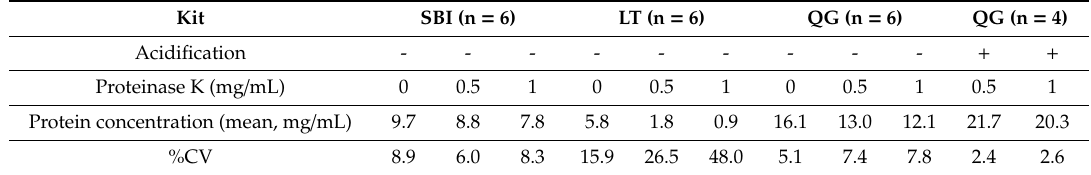
Table 2. Comparison of protein concentration and its variability according to the exosome-like extracellular vesicle (ELV) preparing methods. QG, miRCURY Exosome Serum / Plasma Kit; SBI, ExoQuick Exosome Isolation Kit for Serum and Plasma; LT, Invitrogen ™ Total Exosome Isolation Kit.